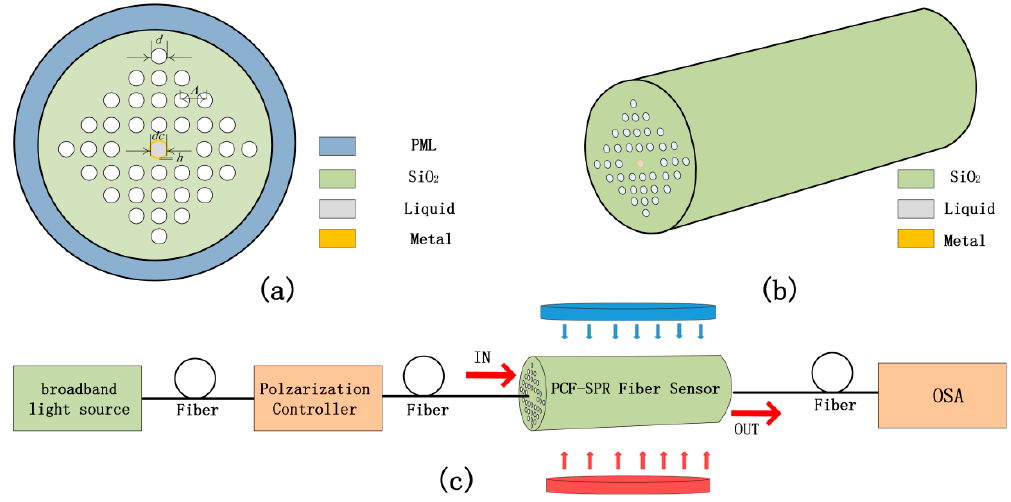
Figure 1. ( a ) The cross section of the proposed photonic crystal fiber-surface plasmon resonance (PCF-SPR) sensor; ( b ) Schematic diagram of the proposed PCF-SPR sensor in three-dimensional (3D) model; and, ( c ) Schematic diagram of the experimental set-up of the proposed sensor.